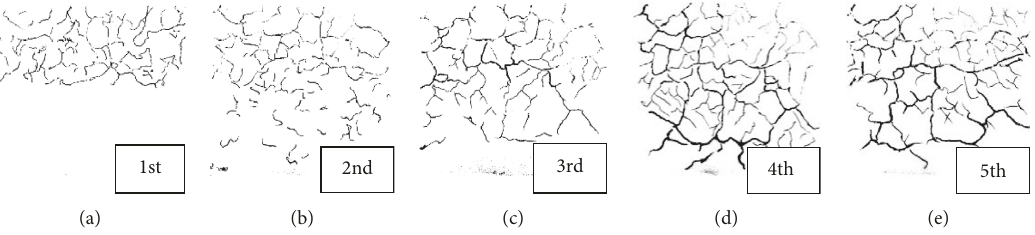
Figure 11: Depiction of surface cracks at the end of each D-W cycles in Model